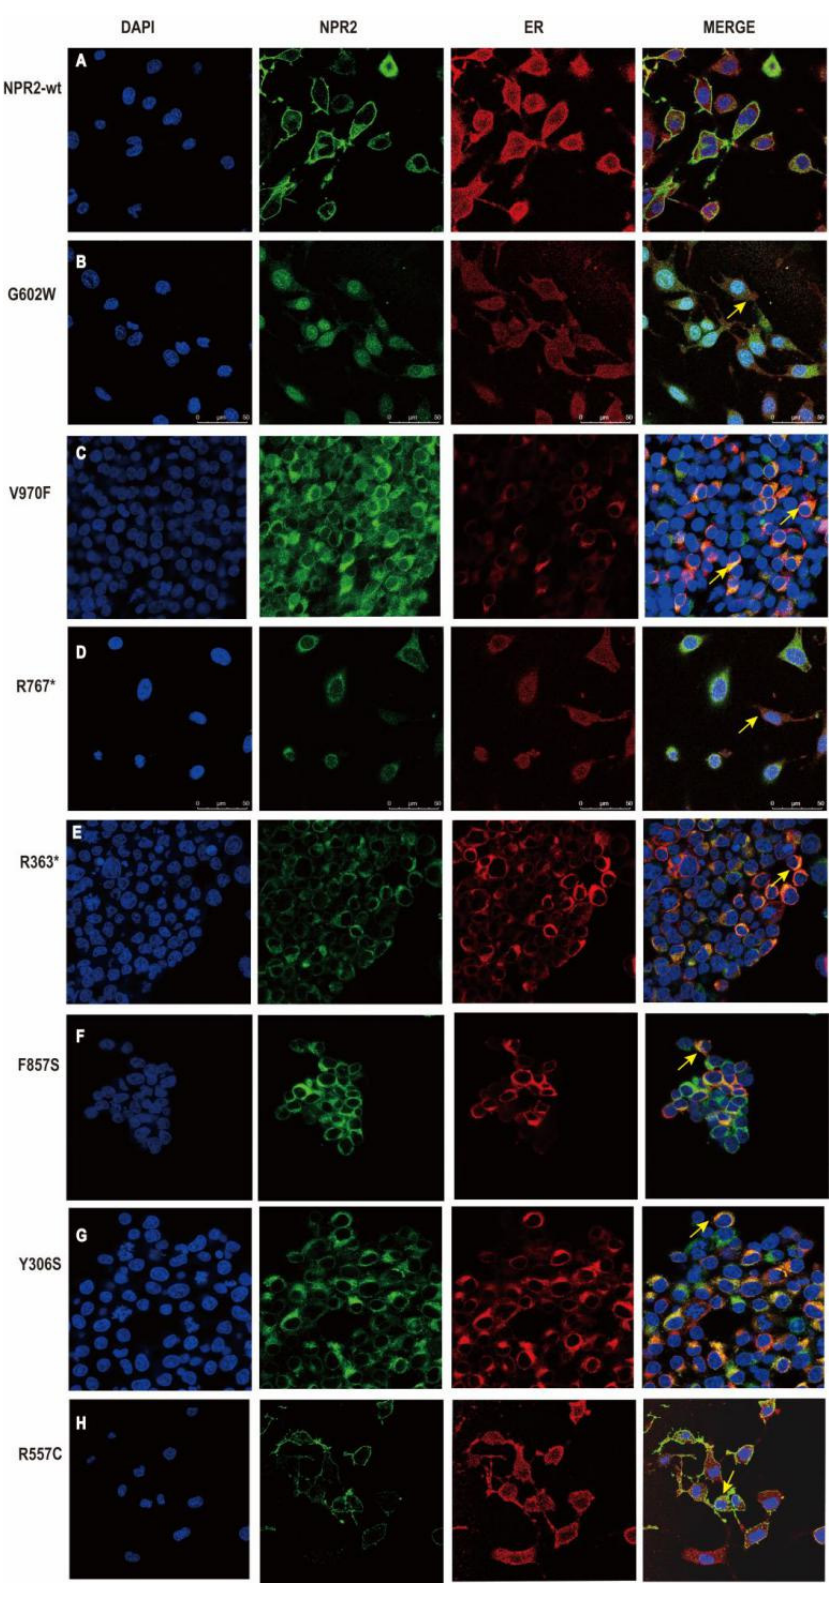
Figure 5. Subcellular localization of natriuretic peptide receptor 2 (NPR2) proteins in HEK293T cells. ( A – H ) Except NPR2 R557C , the remaining variants transfected into HEK293T cells lead to accumulation of NPR2 protein (green marker) in the endoplasmic reticulum (ER, red marker). DAPI—diamino-2- phenylindole;